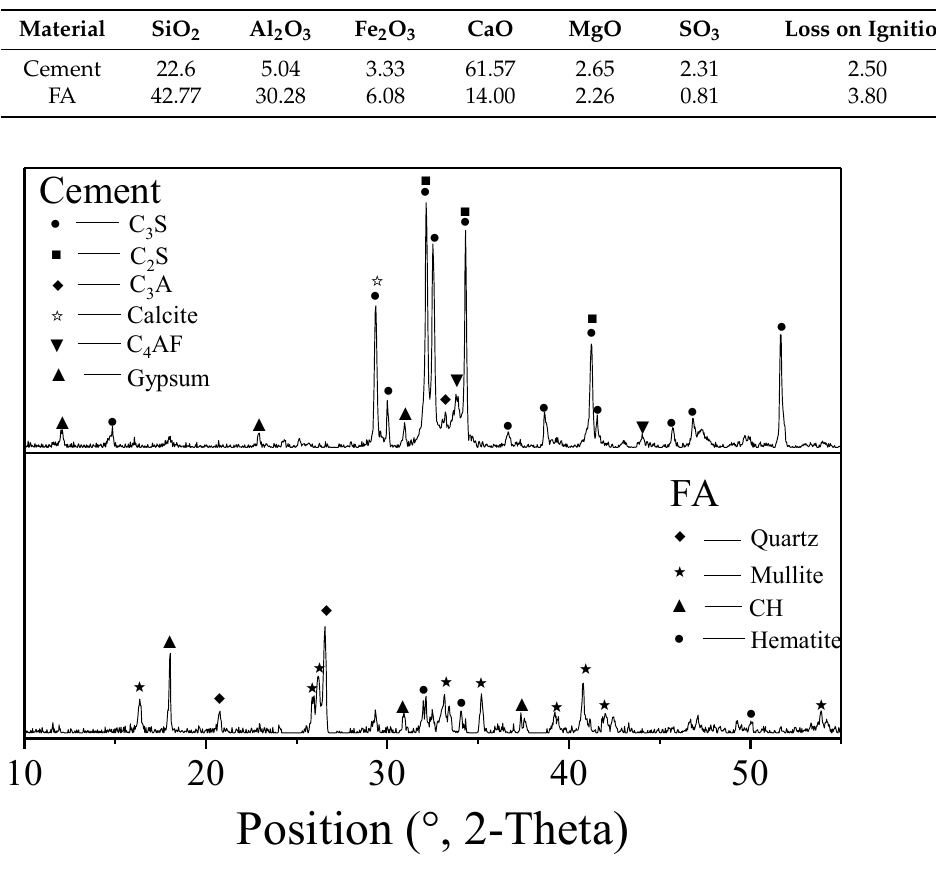
Figure 1. XRD pattern of raw materials.